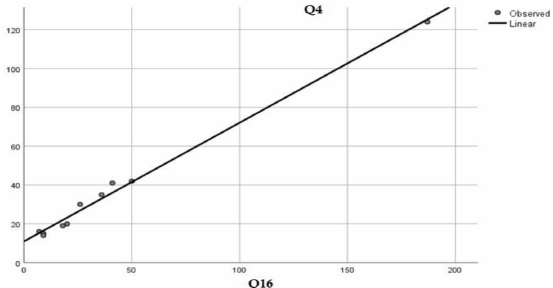
Q4 - Are you afraid of a possible war between Romania and the